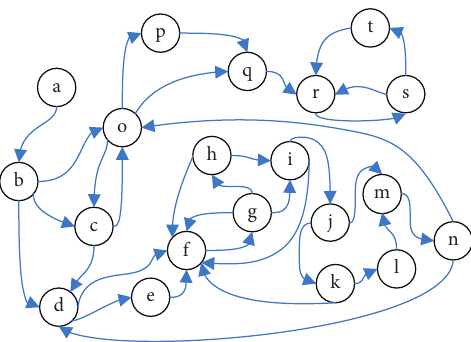
Figure 7: Directed diagram of service touchpoints in the convenience store